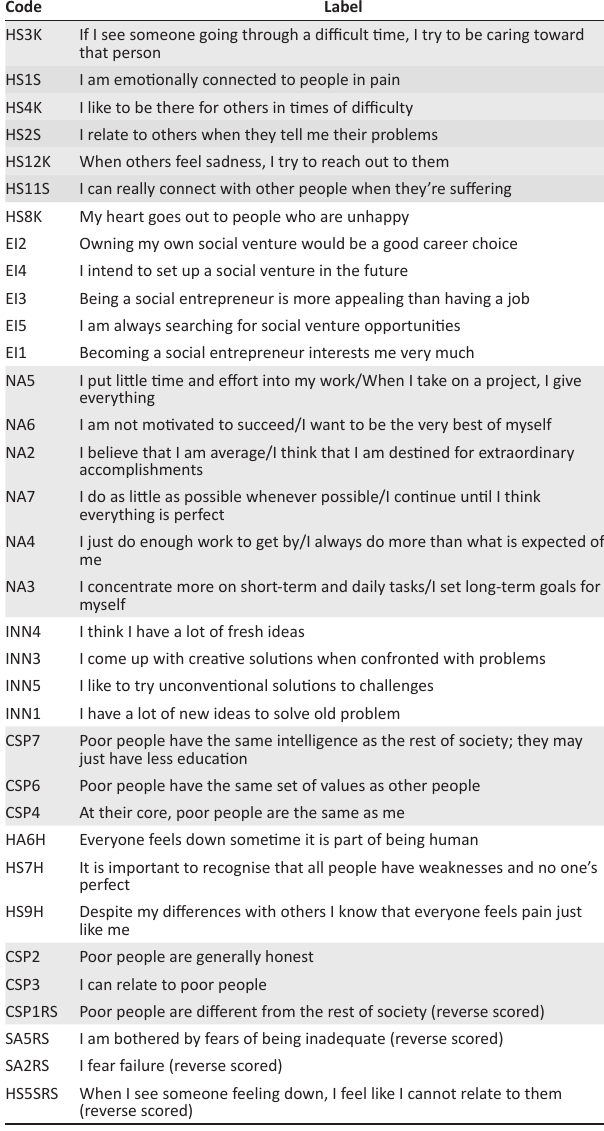
TABLE 1-A1: Items used in the study.